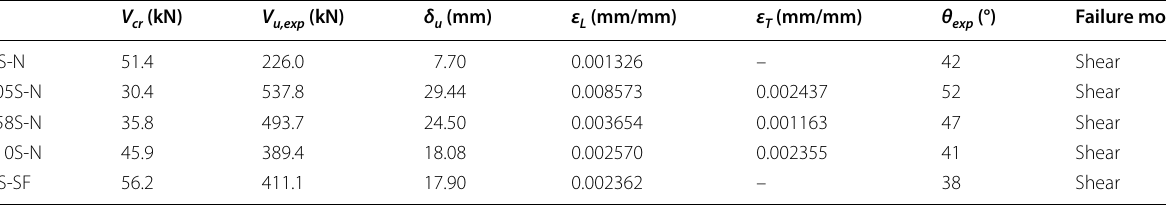
Table 8 Summary of beam test results.